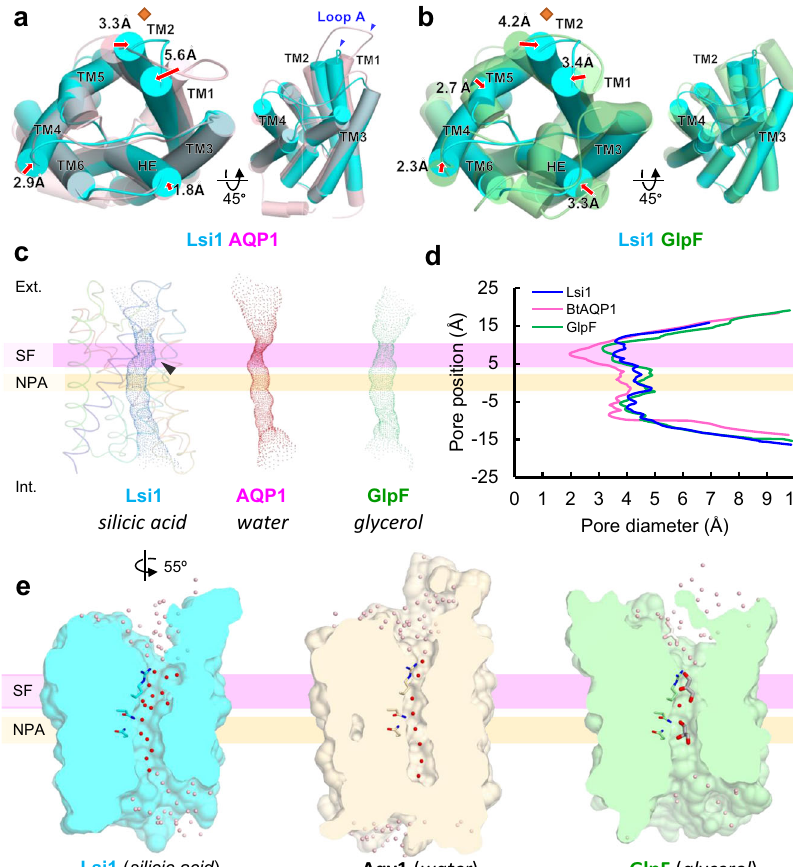
Fig. 2 Comparison of the structures of Si channel Lsi1 and other AQPs. Superposition of the structure of Lsi1 cryst (cyan) with AQP1 (pink, PDB 1J4N) ( a ), and GlpF (light green, PDB 1FX8) ( b ). Top view from the extracellular side (left) and a rotated view by 45° against the membrane normal (right). Arrowheads indicate loop A and red arrows represent the shift of TM helices (in Å). A diamond shape represents a pseudo- C 4 symmetric axis. Channel pro fi le ( c ) and diameters ( d ) along the pore for Lsi1 cryst , AQP1, and GlpF, calculated using the program HOLE2, are shown. The regions for SF and NPA motifs are colored in plum and khaki, respectively. An arrowhead indicates the distortion in the channel. e Cross-section of the channel of Lsi1 cryst , Aqy1 (wheat, PDB 3ZOJ), and GlpF with a 55° rotation relative to ( c ). Water molecules in the channel (red), extra/intracellular regions (pink), and glycerol molecules are shown. In e , N-terminal and C-terminals of Aqy1 were omitted for clarity. The color coding shown here is used for all Figures unless otherwise